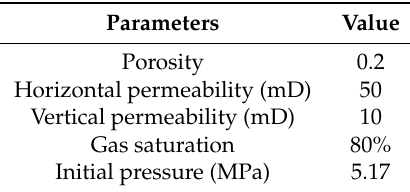
Figure 2. ( a ) Five-spot pattern depicting the CO 2 injection well and the production wells; ( b ) a quarter model of the reservoir in the Ulleung basin (modified from [20]). Table 1. Reservoir parameters [20].